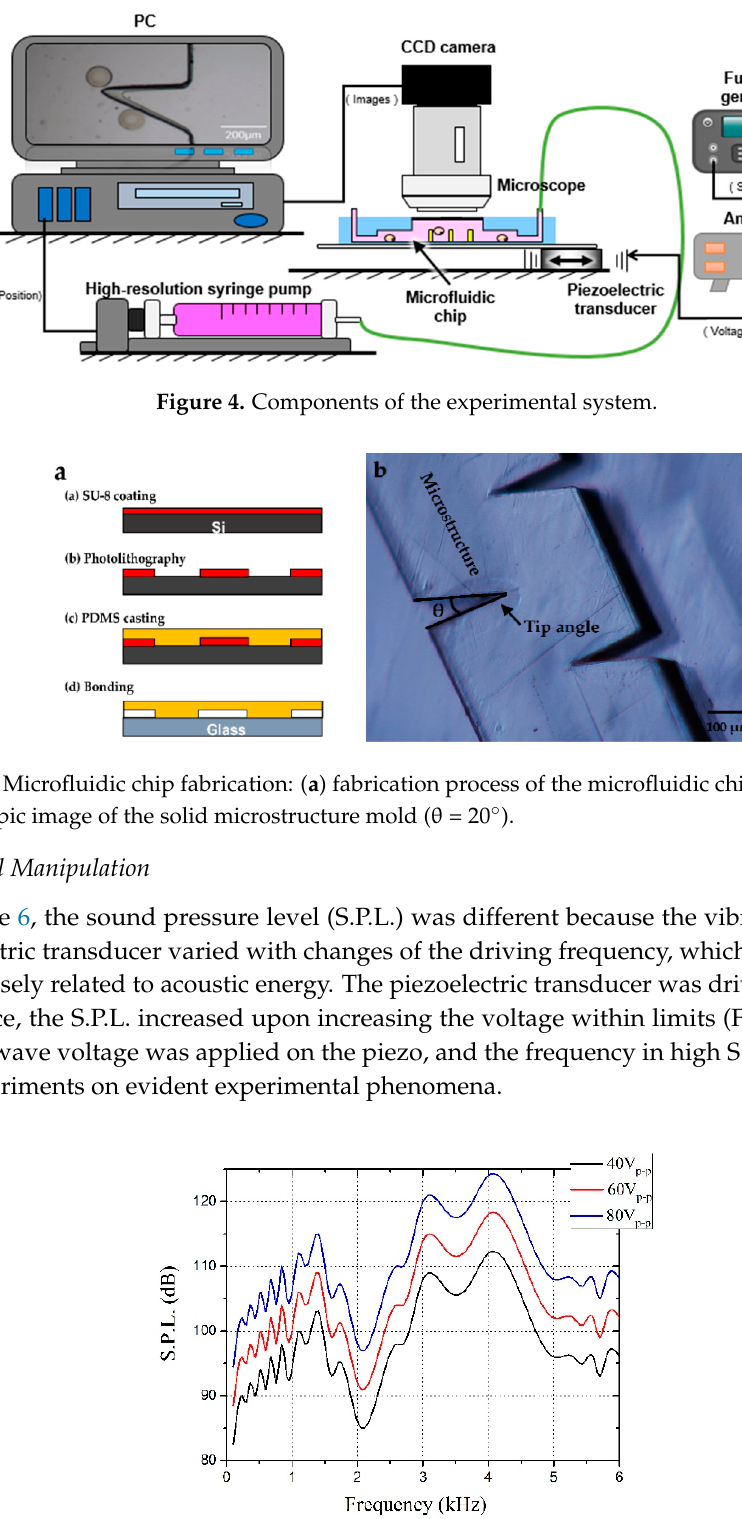
Figure 7. ( a – d ) Rotational manipulation of the diatom cell at 4.6 kHz and 20 V p-p .